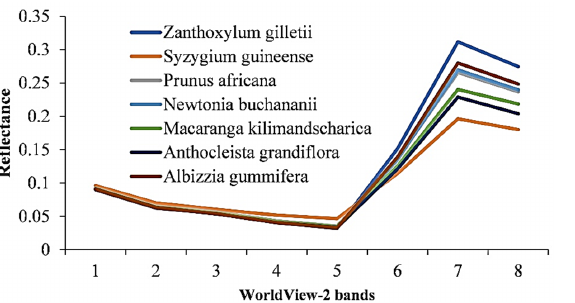
Figure 3. Tree species mean spectral signatures derived from the WorldView ‐ 2 data.